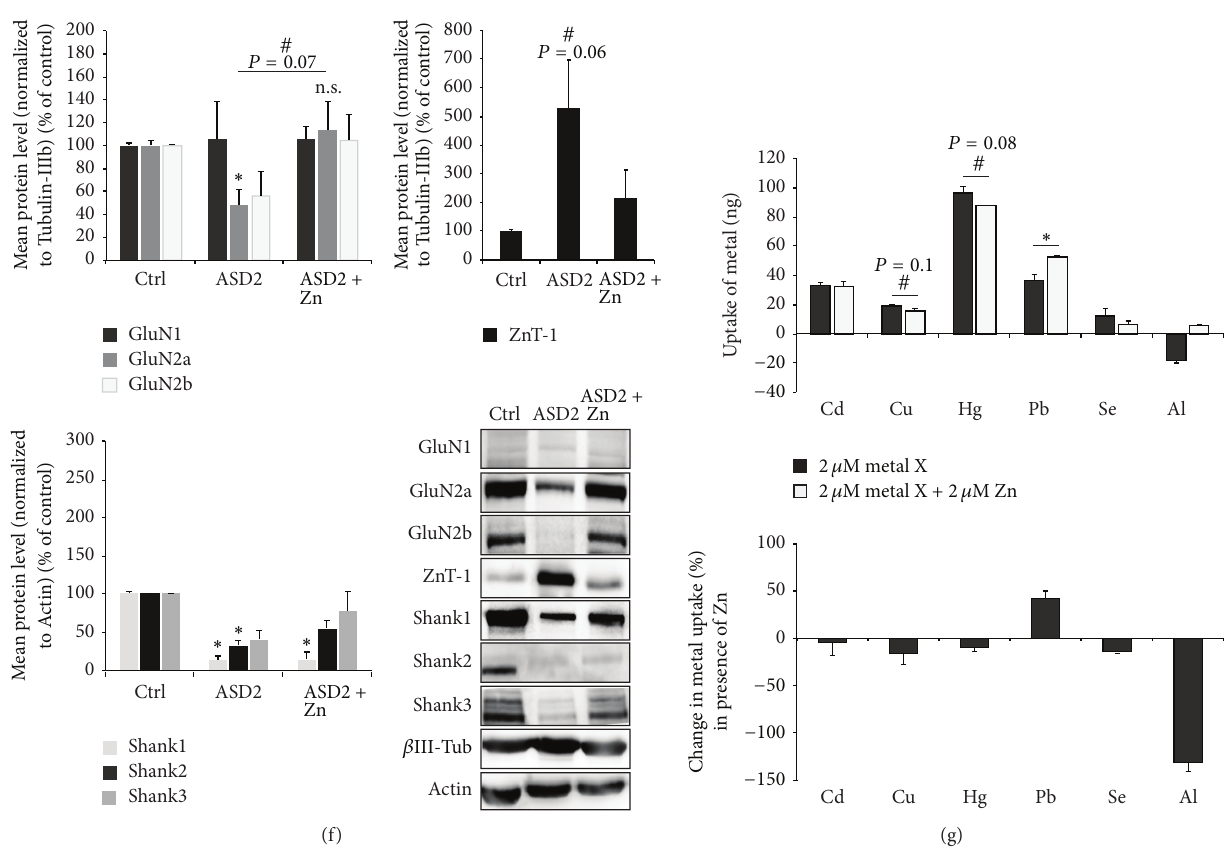
Figure 4: Synergistic and antagonistic relationships between trace metals and Zn. Hippocampal neurons were grown from DIV 10 to DIV 14 in cell culture media containing different sets of trace metals: control cells (Ctrl) were grown in trace metal depleted Neurobasal medium that was reconstituted for all depleted trace metals (Mg, Ca, Fe, and Zn) according to the manufacturer’s indicated metal concentrations. ASD2 cells were grown in trace metal depleted Neurobasal medium that was reconstituted only for Mg and Ca, with addition of the putative toxic metals (0.5 𝜇 M Cd, Cu, Hg, and 2 𝜇 M Pb). ASD2 + Zn cells were grown in ASD2 medium except that 50 𝜇 M Zn was added to the medium. The amount of cell death was calculated assessing the number of neuronal apoptotic nuclei (identified by MAP2 and DAPI staining) per optic field (from 5 fields of view) normalized against the total number of neurons per optic field. A significant reduction in cell health can be observed in cells deficient in Fe and Zn and subjected to toxic metals (ASD2). Zn addition was unable to rescue the observed cell death (ASD2 + Zn). (b) The number of primary, secondary, and tertiary dendrites was investigated from 10 cells per condition. Cells were stained with MAP2 antibody. As signs of cell death, neurons show fragmentation (pinching off) dendrites, starting with branches more distal from the soma. Dendrites showing signs of fragmentation were not counted. The significant reduction seen under ASD2 conditions could be rescued significantly by addition of Zn. (c) Synapses were labeled using Bassoon and Homer1b/c fluorescence and the number of immunoreactive puncta was measured per 10 𝜇 m dendrite length on primary dendrites (3 dendrites per cell, 10 cells in total per group). A significant reduction can be seen in cells growing in medium resembling the biometal profile found in ASD patients (ASD2). Addition of Zn rescues the effects seen on synapse density. (d) Expression levels of NMDA receptor subunits (GluN1, GluN2a, and GluN2b) and SHANK genes (Shank1, Shank2, and Shank3) were measured by qRT-PCR. Virtual mRNA concentrations are shown averaging from three replicates and normalized against HMBS. Supplementation of Zn was able to significantly increase the reduction in mRNA levels seen in cells growing under ASD2 conditions. However, in all cases, mRNA levels still remained significantly decreased compared to controls for NMDAR subunits GluN1 and GluN2a. The expression levels of Shank family members were rescued completely (Shank1 and Shank3). (e) Zn supplementation on DIV 10–14 did not significantly alter fluorescence intensities of synaptic puncta. (f) Analysis of protein expression levels in synaptic (P2) fractions of NMDAR subunits, proteins of the Shank family, and ZnT-1 from three independent experiments normalized against 𝛽 -III-tubulin or actin. Neurons grown in ASD2 medium show a significant reduction of GluN2a receptor subunits and a trend towards a decrease of GluN2b, which is rescued by supplementation of Zn. Similarly, synaptic ZnT-1 levels decrease almost to control levels in ASD2 medium with Zn compared to ASD2 Zn deficient medium. The expression of Shank proteins is reduced under ASD2 conditions and the synaptic concentration of Zn-dependent Shank2 and Shank3 family members is restored by Zn supplementation such that Shank2 levels are no longer significantly decreased under ASD2 + Zn condition (lower left panel). Exemplary bands are shown in the lower right panel. (g) Using ICP-MS, the extracellular metal concentrations of hippocampal cell cultures ( 𝑛 = 3 per metal, Mann-Whitney 𝑈 test) was measured with and without the presence of Zn. A reduction in the uptake of Cu, Hg, and Se was seen as trend upon coapplication of Zn, while an increase in uptake of Pb was